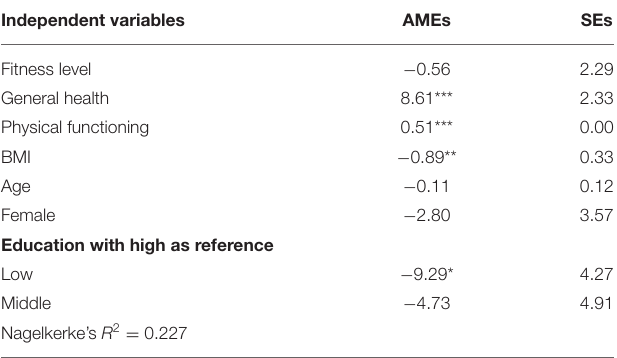
TABLE 2 | Logistic regression of observed compliance with the squat task. Independent